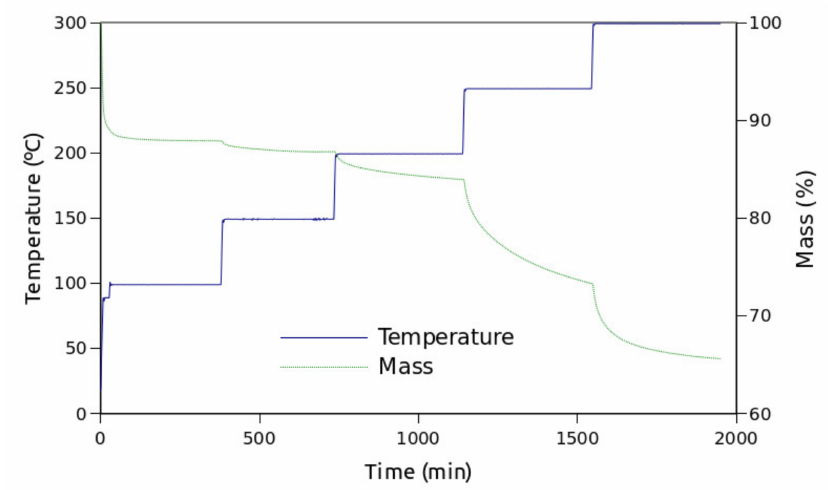
Figure 6. TG plots obtained in a stairway